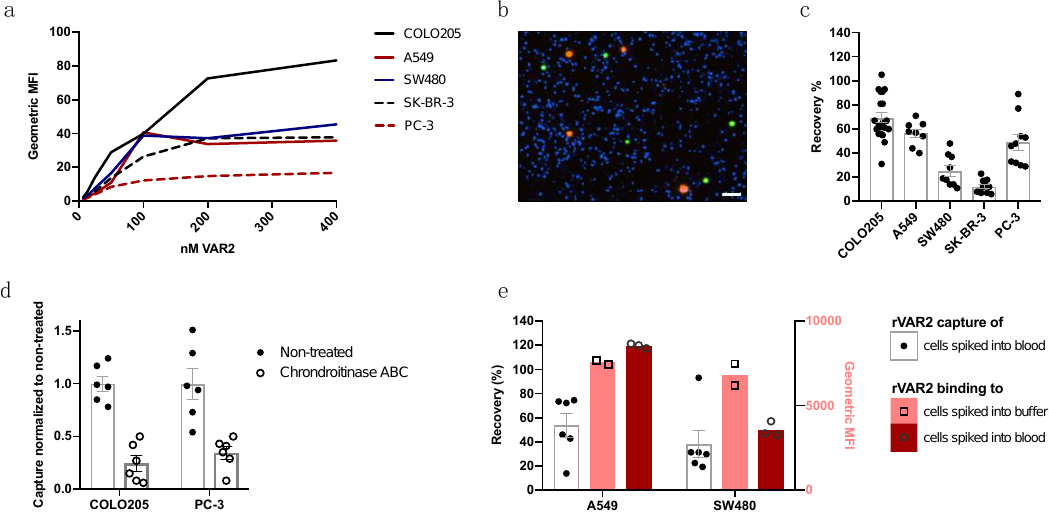
Figure 4. rVAR2 binds to and captures a variety of cancer cell lines when coupled to magnetic beads. ( a ) Flow cytometry shows rVAR2 binding to five cancer cell lines in buffer determined by anti-V5 FITC antibody geometric mean fluorescence intensity. Results are presented as mean of duplicates. ( b ) Representative image of captured COLO205 cells (green) and A549 cells (orange) in a background of DAPI+ white blood cells (blue). Image is taken with a 4× objective, Cytation 3. Scale bar 50 μm. ( c ) rVAR2-based recovery of the five different cell lines COLO205 ( n = 20), A549 ( n = 8), SW480 ( n = 9), SK-BR-3 ( n = 12) and PC-3 ( n = 10) from 3 mL blood samples. Each dot represents a sample recovery and error bars show +/- SEM. ( d ) Recovery of COLO205 and PC-3 with or without chondroitinase ABC pre-treatment. Chondroitinase ABC-treated samples were normalized to the mean of the recovery for the non-treated samples. Each dot represents a sample recovery and error bars show +/ - SEM. ( e ) Parallel experiment on cell-matched samples on rVAR2-based capture of 100 CTO + A549 or SW480 cancer cells in 3 mL of blood (black) and test of 200 nM rVAR2 binding to the CTO + cancer cells in bu ff er (pink) or spiked into blood and RBC-lysed (red). rVAR2 binding was measured by anti-V5 FITC staining in flow cytometry (MFI, mean fluorescence intensity). Columns represent mean values and error bars show +/ -